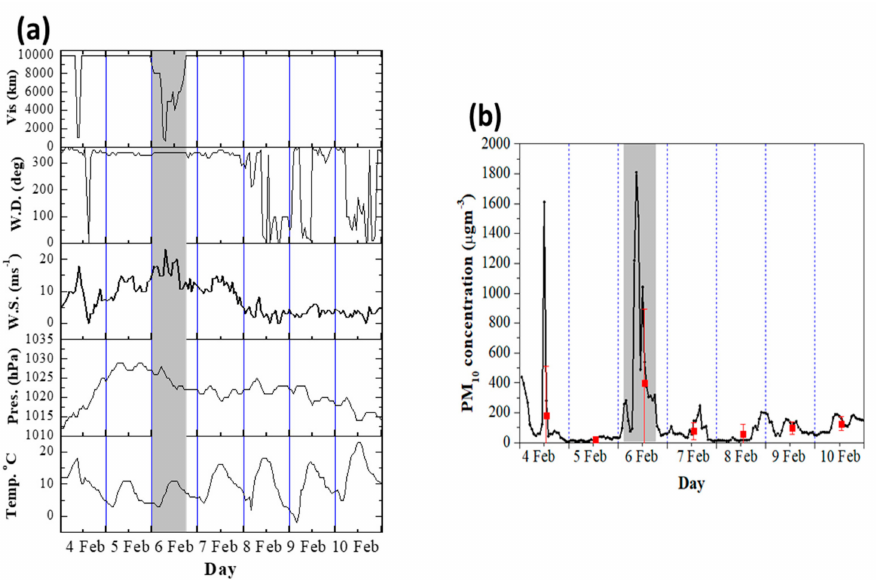
Figure 7. Temporal variation of ( a ) the hourly meteorological parameters and ( b ) hourly PM 10 concentrations in Zabol during 4–10 February 2019. The dust storm hours at the station are highlighted in grey. The red squares with the vertical bars correspond to daily mean +/ − 1 standard